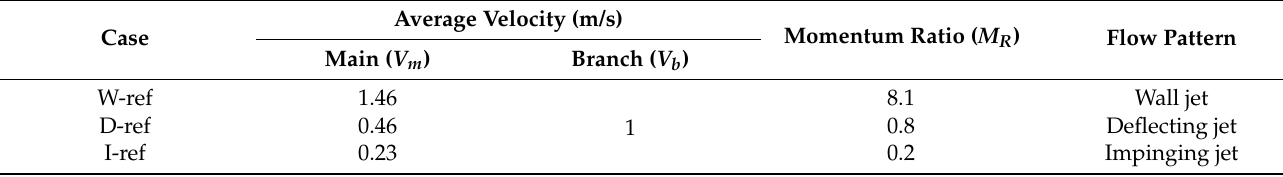
Table 1. Conditions of three typical cases.